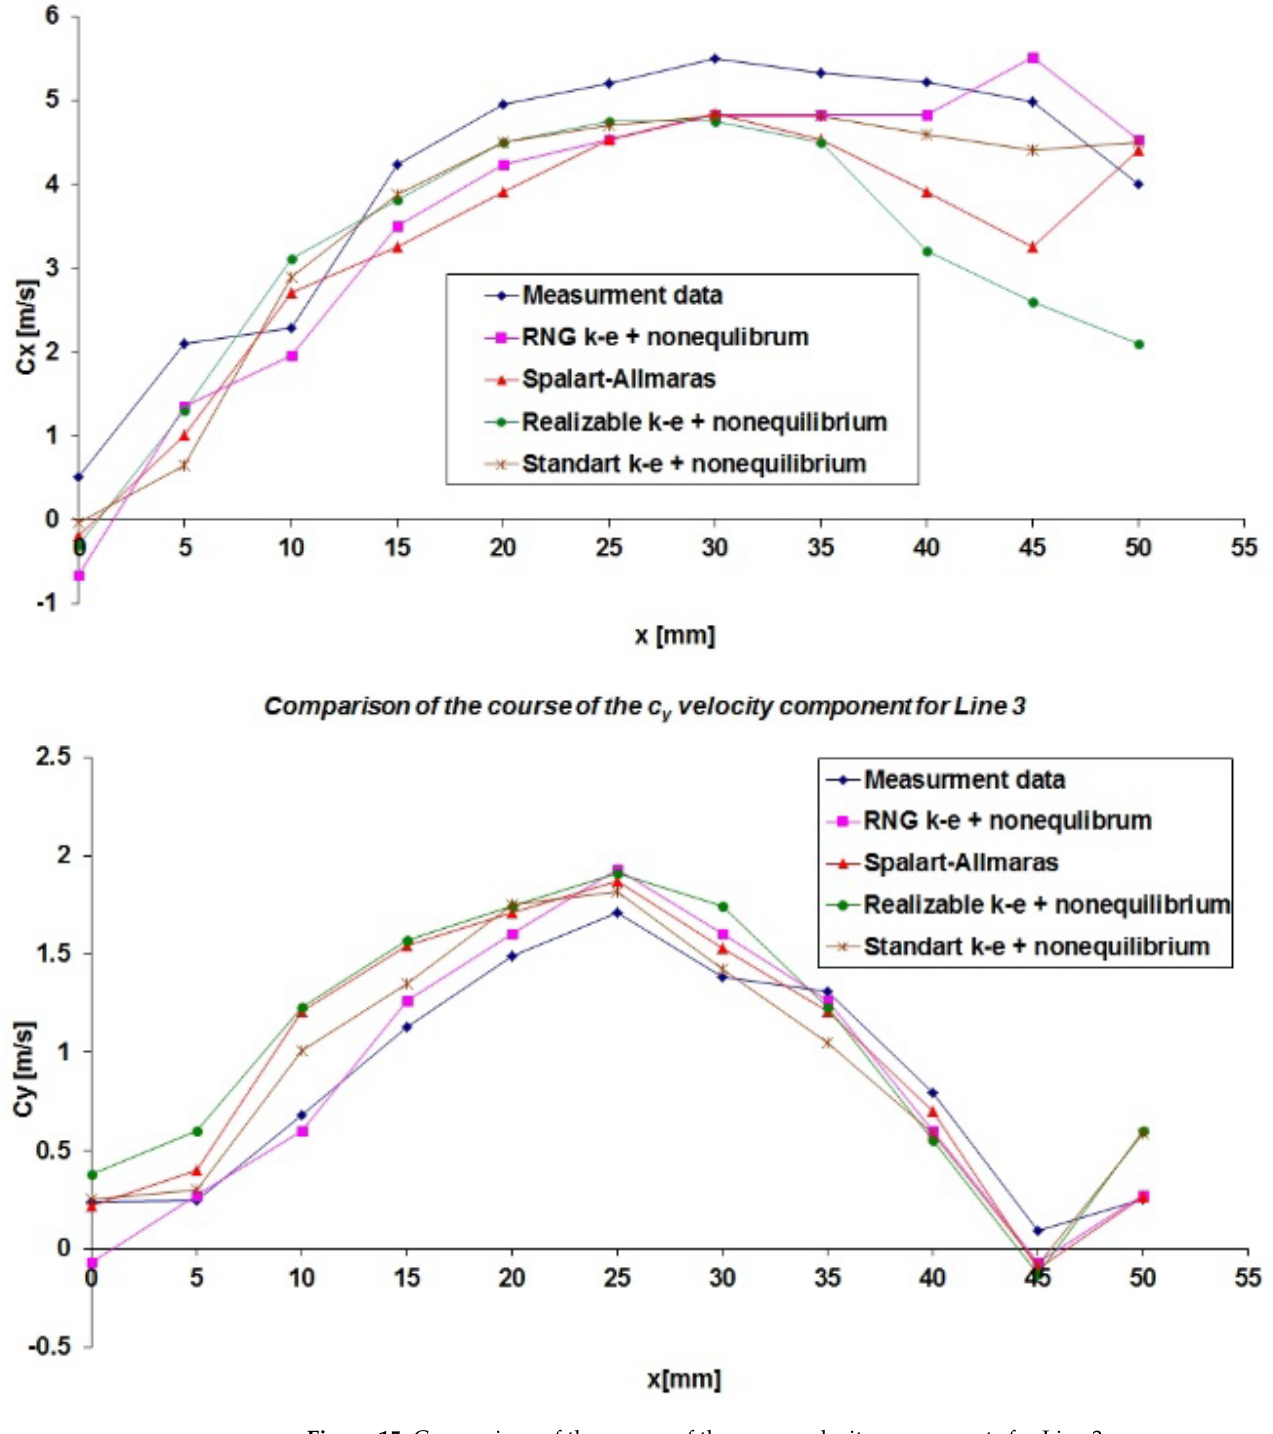
Figure 16. Comparison of the course of the cx, cy velocity components for Line 4.